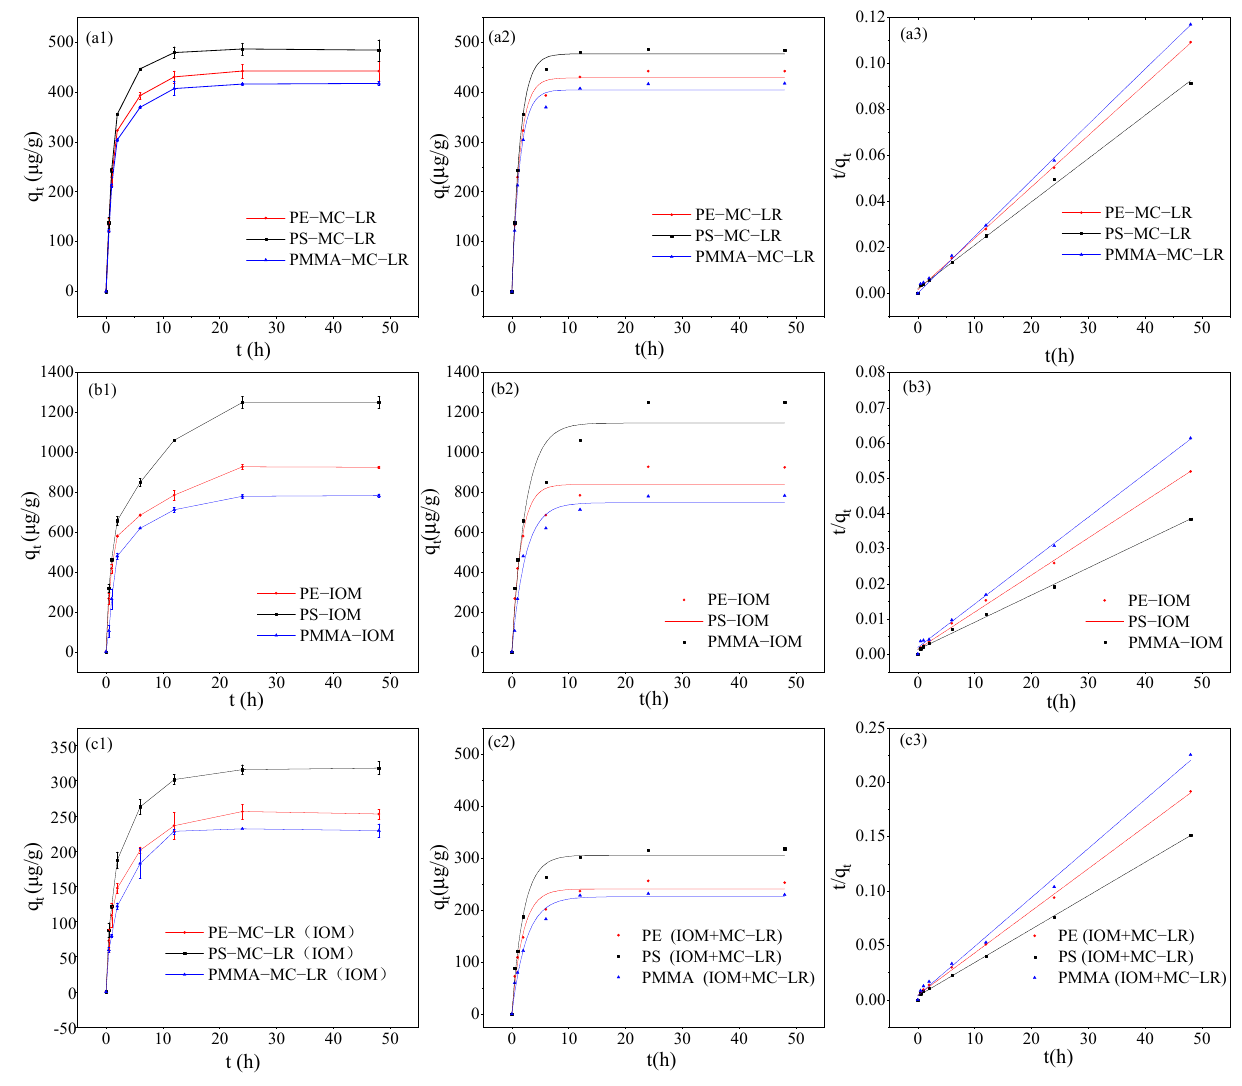
Figure 1. Effect of contact time on adsorption of MC-LR ( a 1), IOM ( a , b ), and MC-LR in the presence of IOM ( c 1) on PE, PS, and PMMA, respectively, and the fitting graphs of adsorption kinetic models: Pseudo-first-order ( a 2– c 2) and Pseudo-second-order ( a 3– c 3).